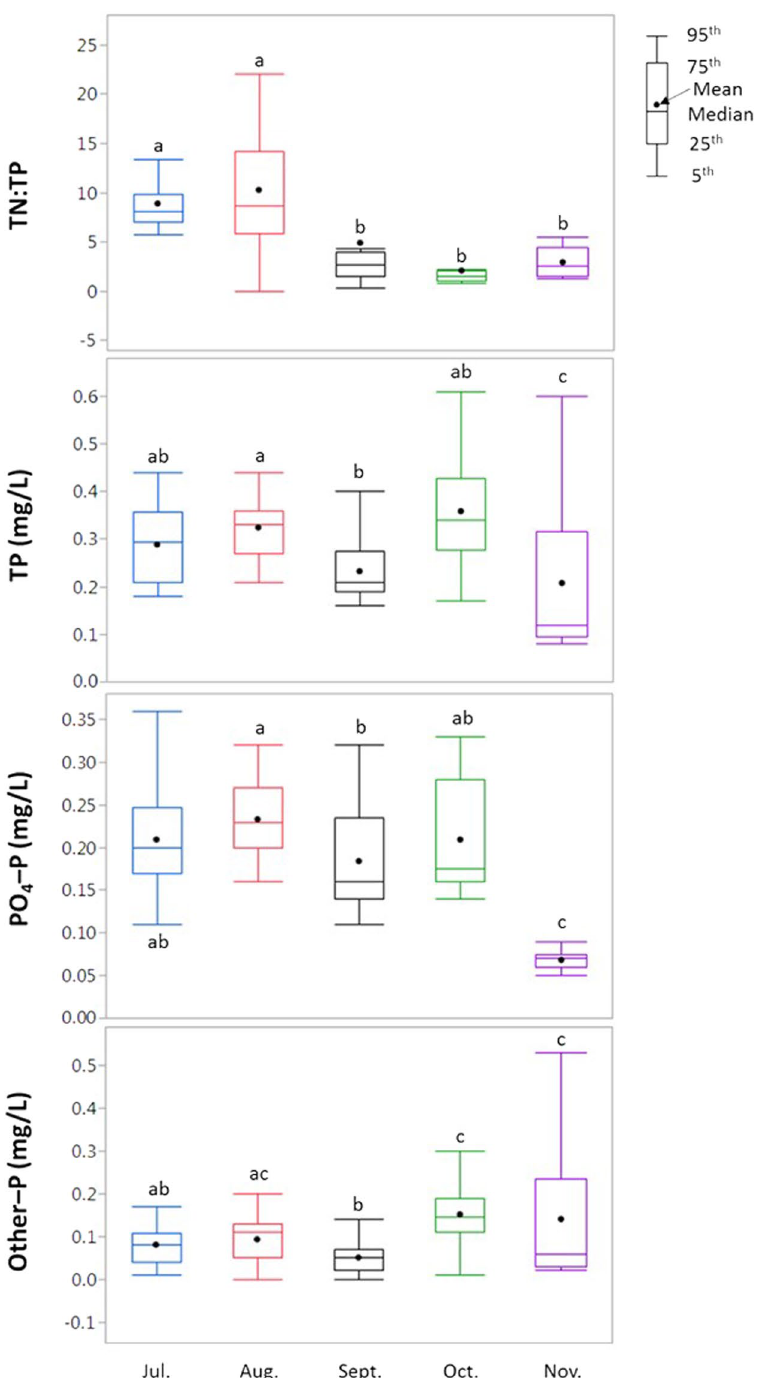
Figure 3. The molar ratio of TN:TP and concentration distribution of P forms in stormwater runoff (n = 153) during July–November 2014. The different letters indicate significant differences among months (AVOVA; p <